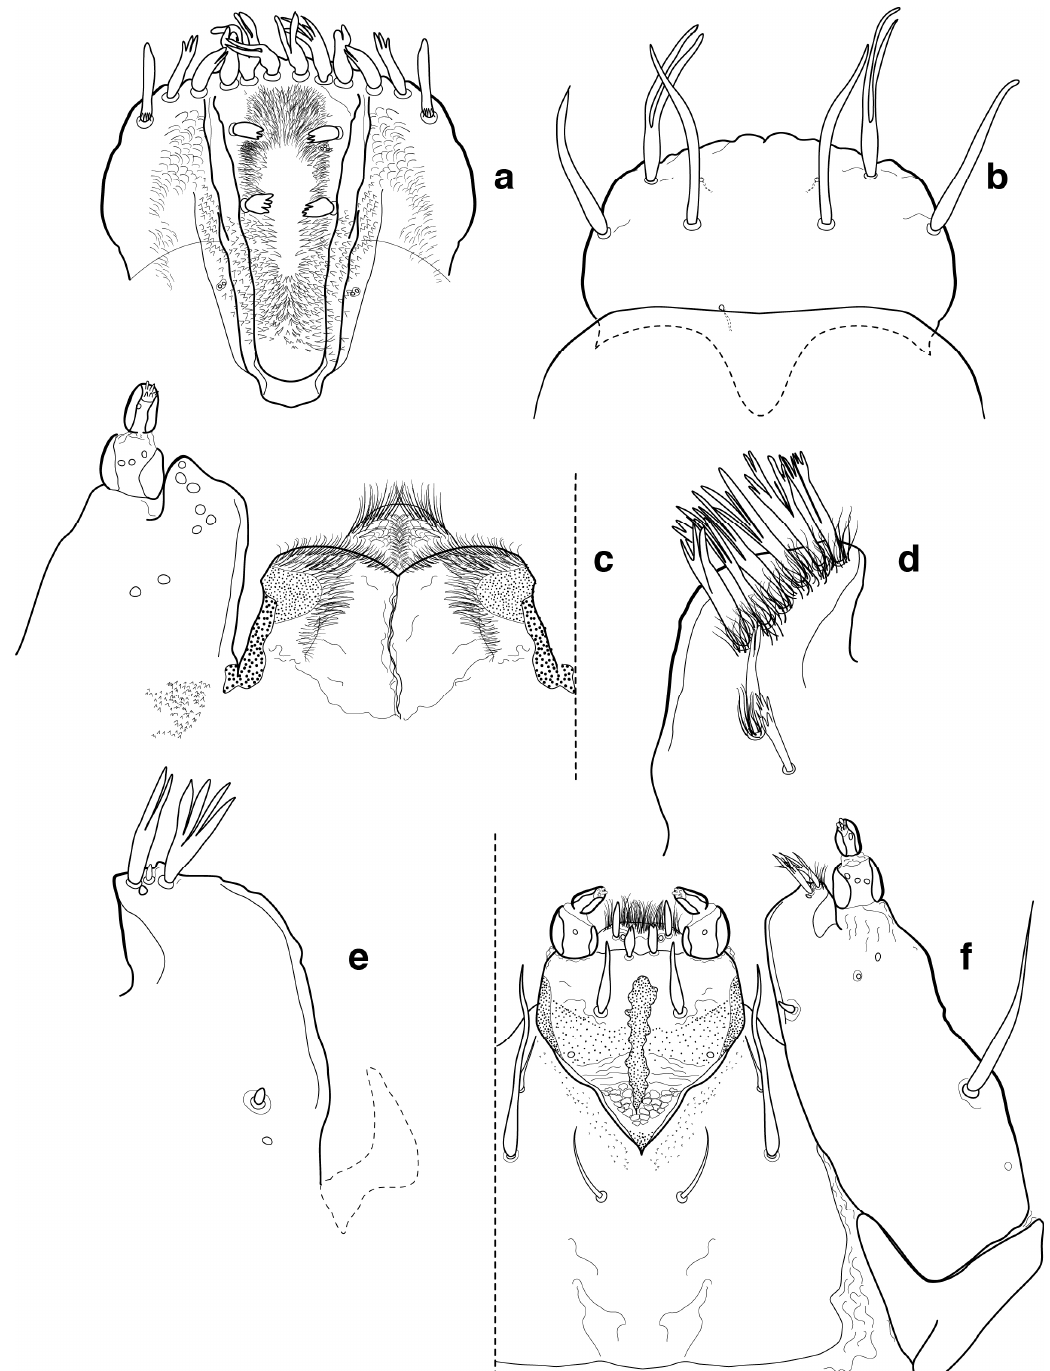
Figure 65. Foveolus c.f. maculatus mouthparts: ( a ) epipharynx; ( b ) clypeus (incomplete) labrum; ( c ) hypopharynx, mala, and maxillary palp, dorsal view; ( d detail of mala and dorsal malar setae; ( e ) detail of mala and ventral malar setae; and ( f ) labio-maxillary complex, ventral view.